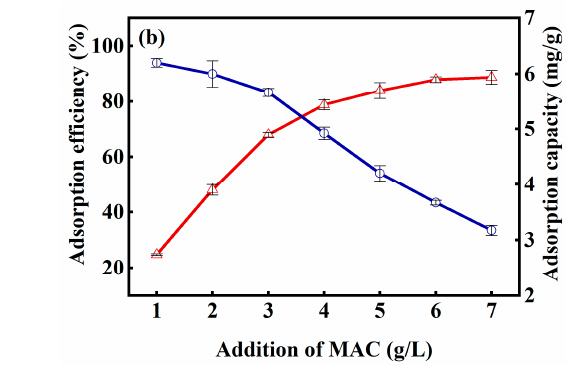
Figure 7. Effect of MAC dosage on adsorption effect: ( a ) Pb ion; ( b ) Cd ion .